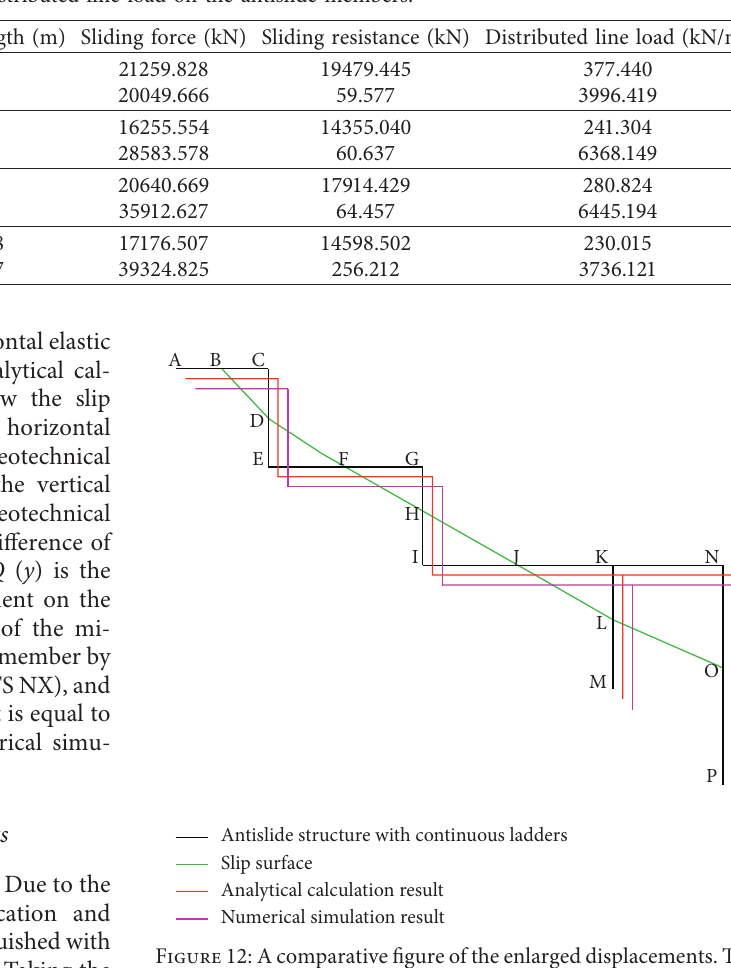
Table 3: The distributed line load on the antislide members.